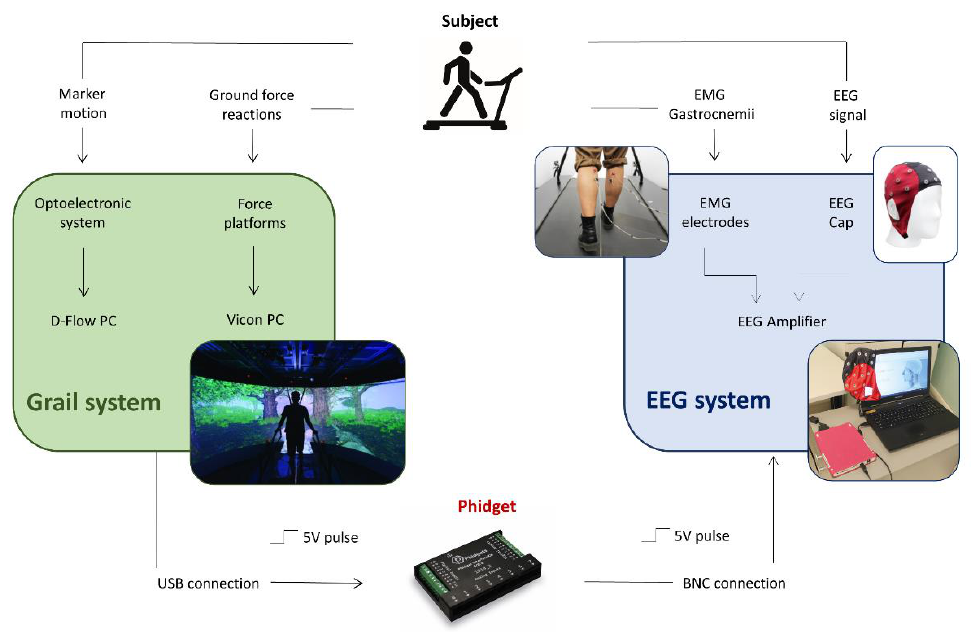
Figure 1. Schematic representation of the GRAIL and EEG system integration.